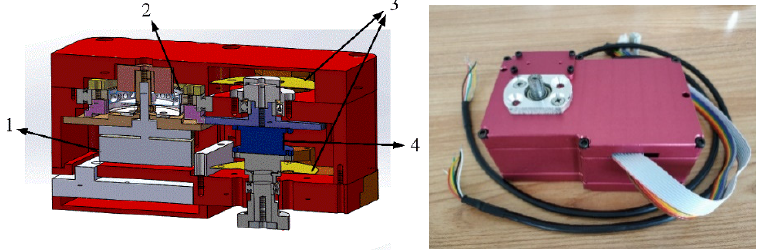
Figure 1. Mechanical structure of our self-designed SVA. The 3D mechanical model of SVA is shown on the left of this figure: (1) motor, (2) harmonic drive, (3) encoder, (4)